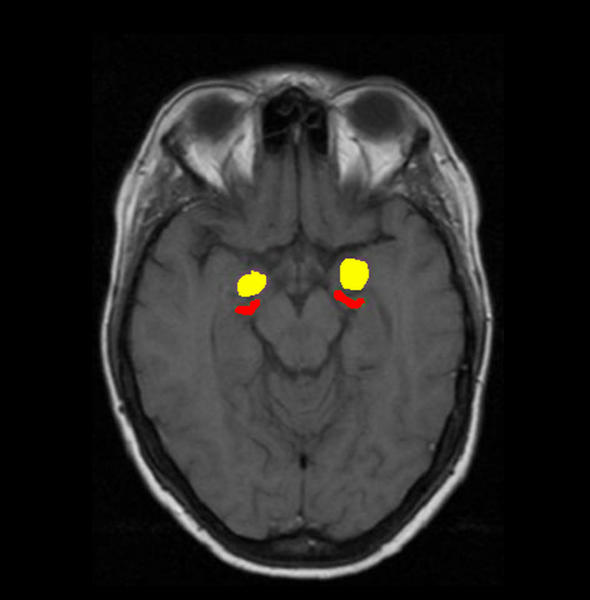
Axial T1 Weighted Anatomical MRI Scan Showing Segmentation of the Amygdala (Yellow) and the Hippocampus (Red)